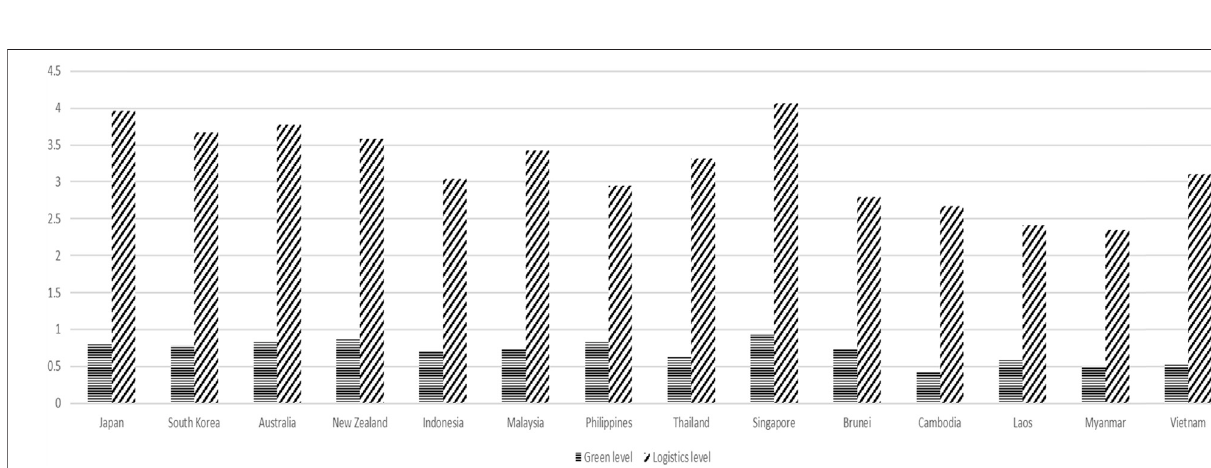
FIGURE 1 | Mean value of GLPI sub-indexes in RCEP sample countries.